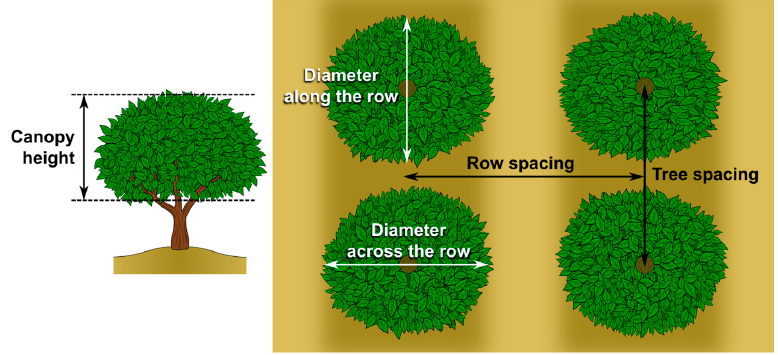
Figure 2. Parameters of the framework and the canopy size of the target orchard that growers have to measure and include in the tool. measure and include in the